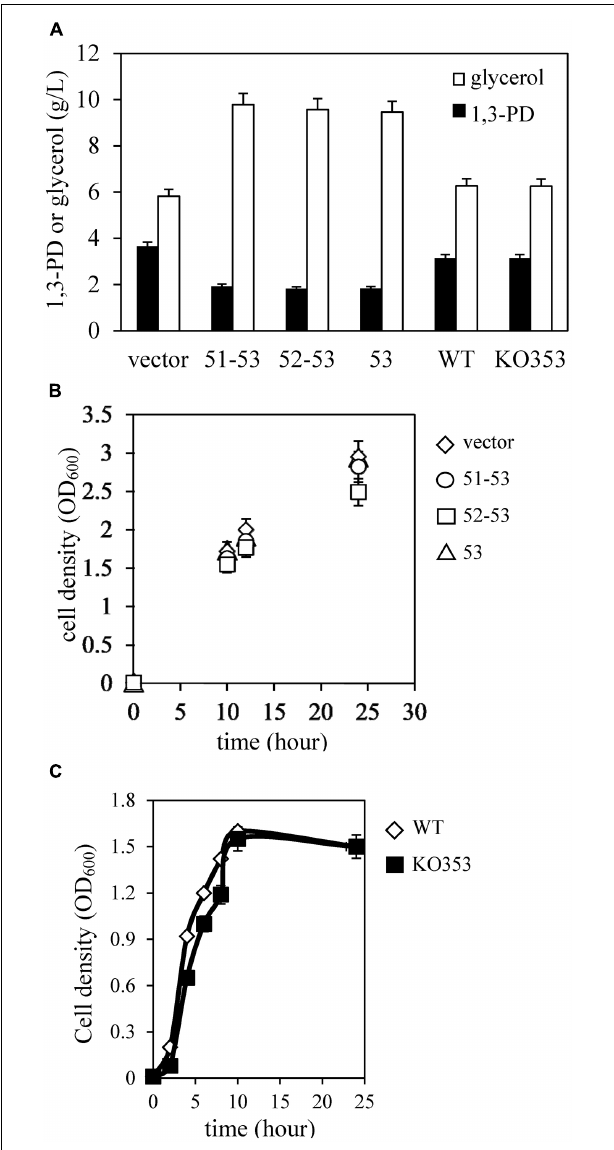
FIGURE 3 | Quantification of 1,3-PD, glycerol and cell density. (A) The amount of 1,3-PD (black bar) and residual glycerol (white bar) in the medium after 12 h of bacterial culture. (B) The bacterial density was measured at OD 600 when the bacteria were inoculated and after growing for 10, 12, and 24 h. vector, K. pneumoniae containing pBSK-Gm as vector control (white diamond). 51–53, K. pneumoniae containing the plasmid pBSK-51–53-GM to overexpress KPN00353, KPN00352 and KPN00351 (white circle). 52–53, K. pneumoniae containing the plasmid pBSK-52–53-GM to overexpress KPN00353 and KPN00352 (white square). 53, K. pneumoniae containing the plasmid pBSK-53-GM to overexpress KPN00353 (white triangle). (C) The bacterial density was measured at OD 600 . White diamond, wild type (WT). Black square, KPN00353 mutant